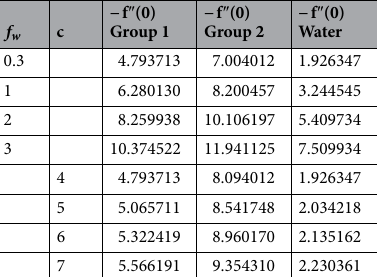
Table 3. Comparison of skin friction coefficient (x-direction) against suction velocity (fw) and stretching ratio (c) for ternary group 1 and